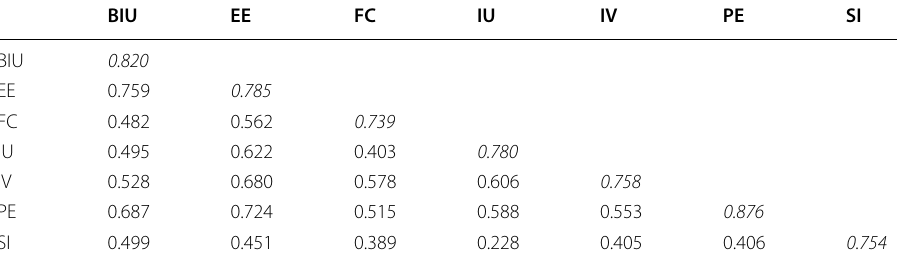
Table 2 Fornell and larcker criterion analysis